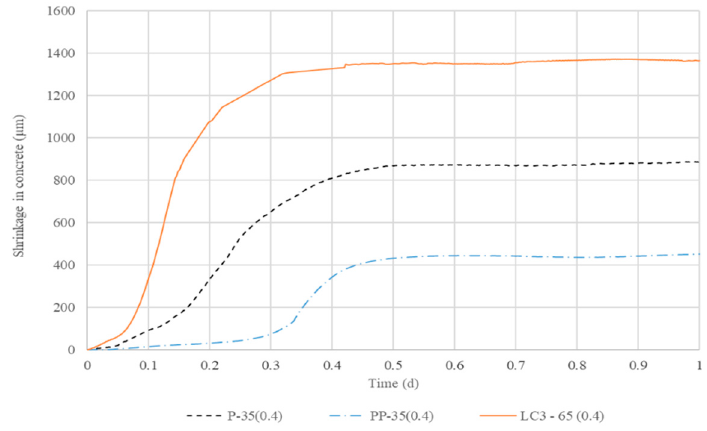
Figure 7. Effect of binder type on concrete shrinkage 24 h.